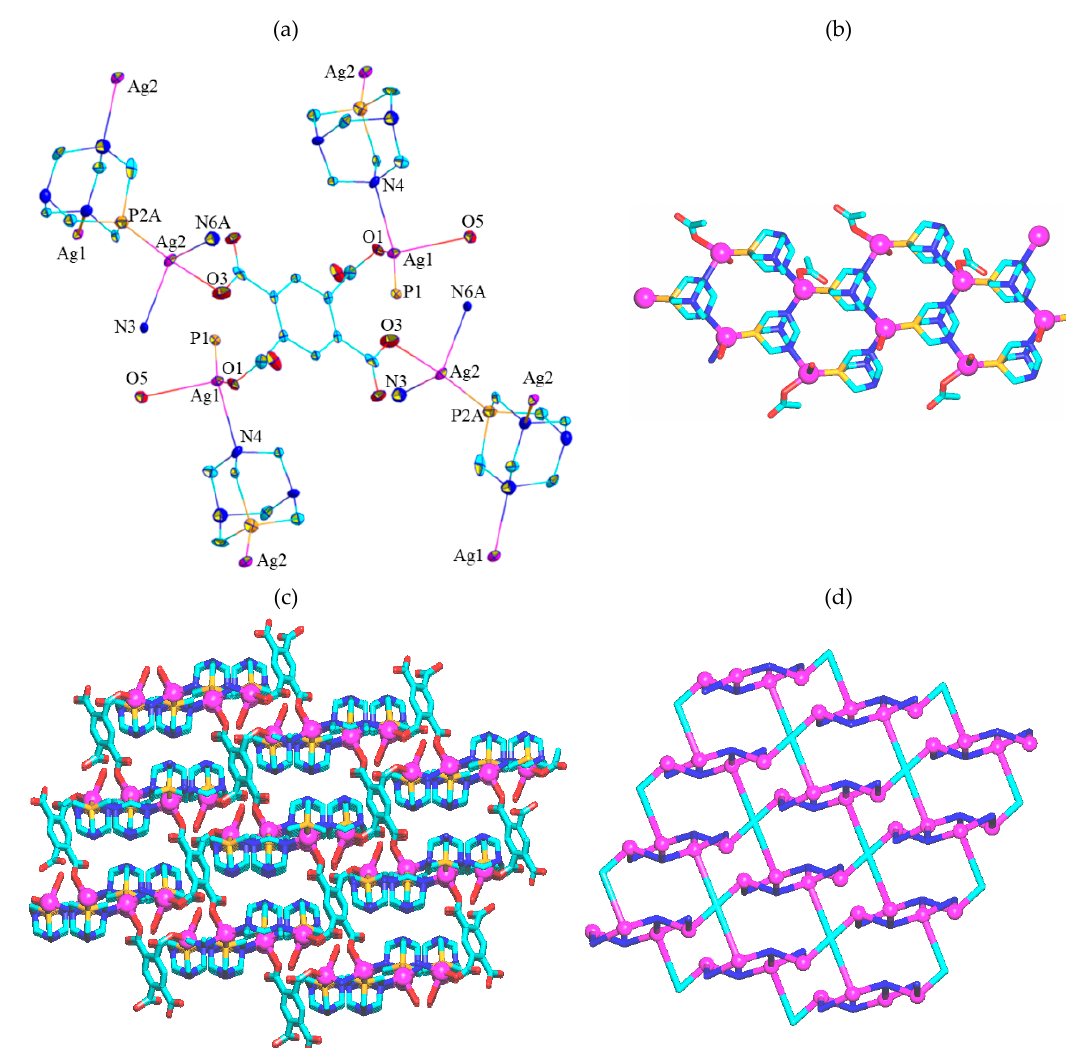
Figure 1. Crystal structure of 1 . ( a ) Connectivity of Ag(I) centers and ligands. ( b ) One-dimensional (1D) chain motif (ribbon) based on honeycomb-like [Ag 3 (PTA) 3 ] n subunits. ( c ) Ribbon-pillared 3D metal-organic framework. ( d ) Topological view of 3D net showing a 3,3,4,4-linked tetranodal framework. Details: (a–c) H atoms and crystallization H 2 O are omitted, Ag (magenta balls), P (orange), N (blue), O (red), and C (cyan); (c, d) view along the b axis; (d) 3- and 4-connected Ag1 / Ag2 atoms (magenta balls), centroids of 4-connected µ 4 -pma 2 − blocks (cyan), and centroids of µ - and µ 3 -PTA blocks (blue).